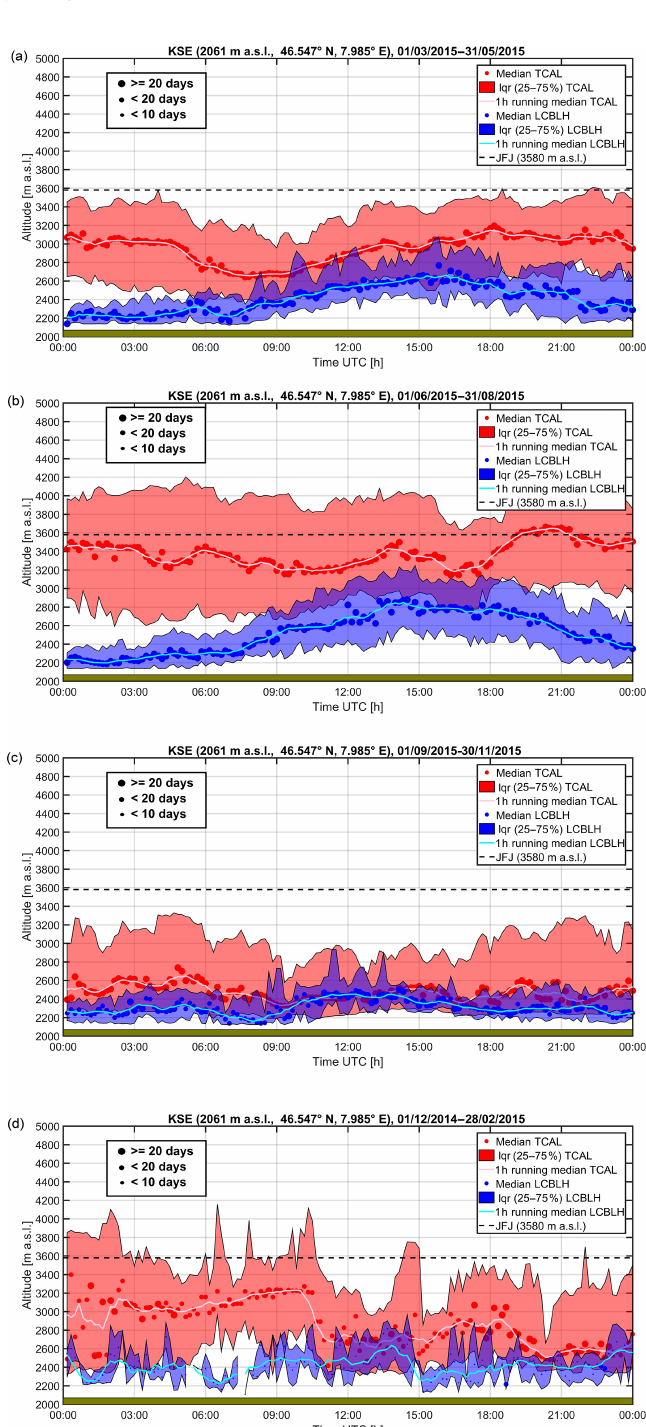
Figure 6. Season-averaged daily cycle of the TCAL (red dots) and of the LCBLH (blue dots) at KSE. The size of the dots corresponds to the number of measurements available in each temporal bin. (a) Spring (March to May); (b) summer (June to August); (c) au- tumn (September to November); (d) winter (January to February). Shaded areas show the 25–75% interquartile range (IQR) for LCBL (purple) and TCAL (red). The altitude of JFJ is indicated by the black dashed horizontal